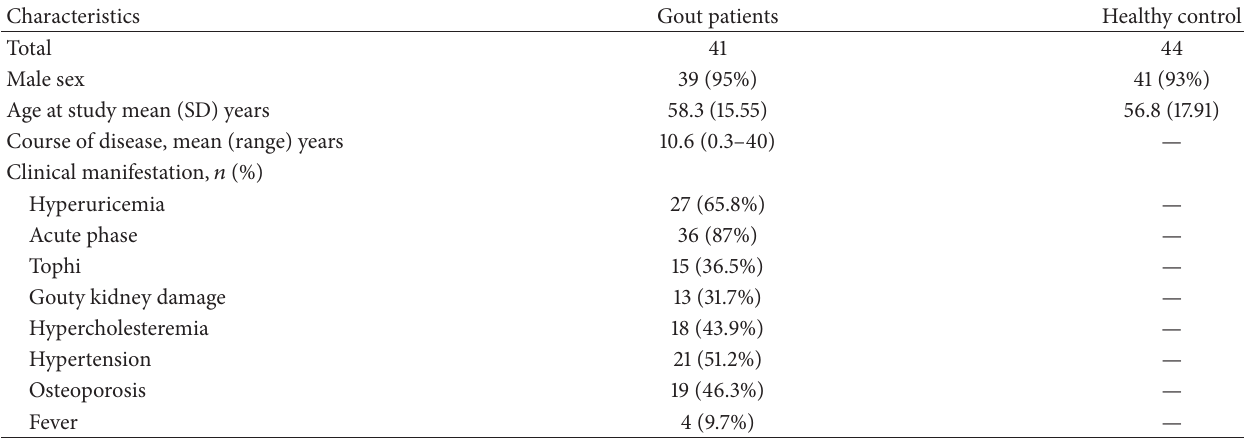
Table 1: Demographic data and clinical characteristics of subjects in the